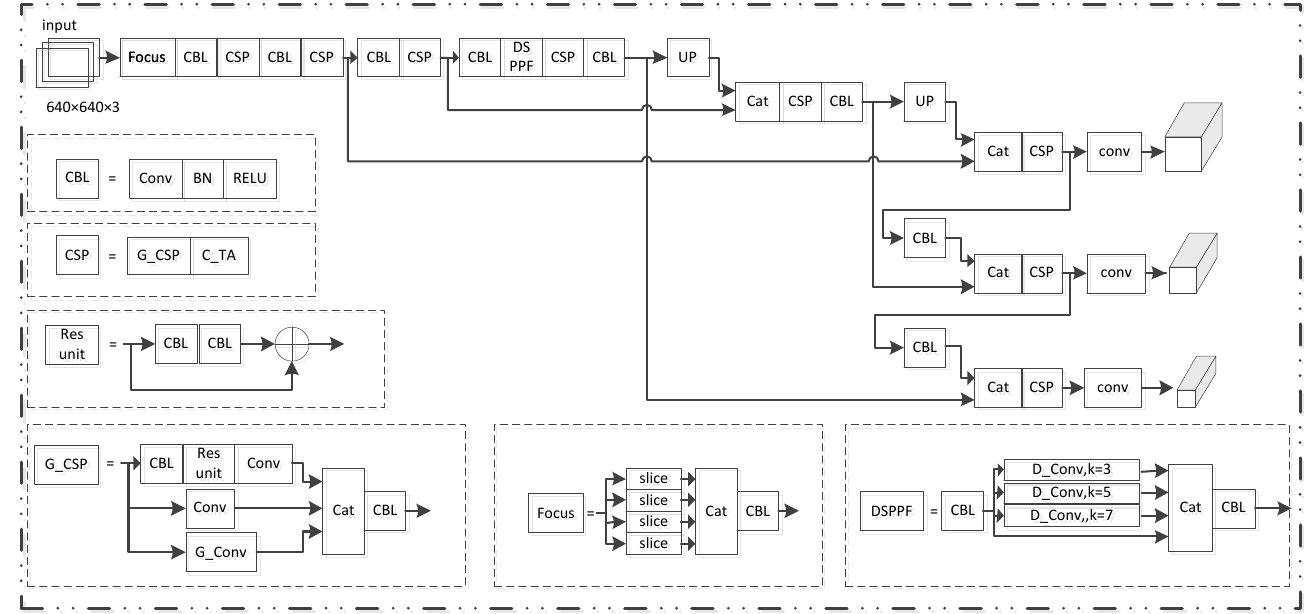
Figure 1. YOLOv5s module. Conv denotes general convolutions operation. BN denotes Batch Normalization. RELU denotes Relu activation function. Res unit denotes residual structure. ⊕ denotes element-wise addition. CSP denotes the cross-stage partial network. G_CSP denotes the ghost cross-stage partial network. C_TA denotes convolutional triplet attention network. DSPPF denotes the dilated convolution with spatial pyramid pooling-fast module. Cat denotes the characteristic concatenation operation. Focus denotes slice operation.